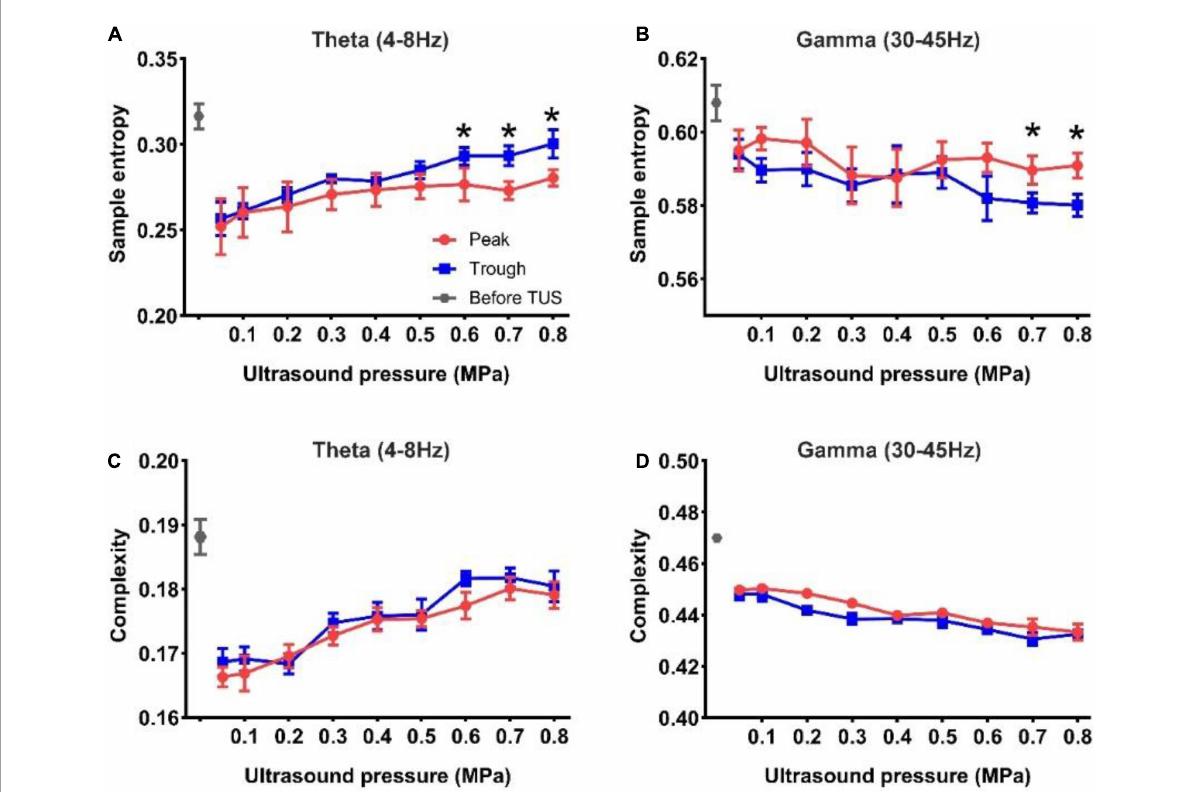
FIGURE4 (A,B) The sample entropy of the theta and gamma rhythms before and after TUS under peak and trough stimulations with different ultrasound pressures, (A) theta rhythm, (B) gamma rhythm. (C,D) The complexity of the theta and gamma rhythms before and after TUS under peak and trough stimulations with different ultrasound pressures, (C) theta rhythm, (D) gamma rhythm. (mean ± SEM, n = 8 for peak stimulation, n = 8 for trough stimulation, * p < 0.05; Kruskal–Wallis